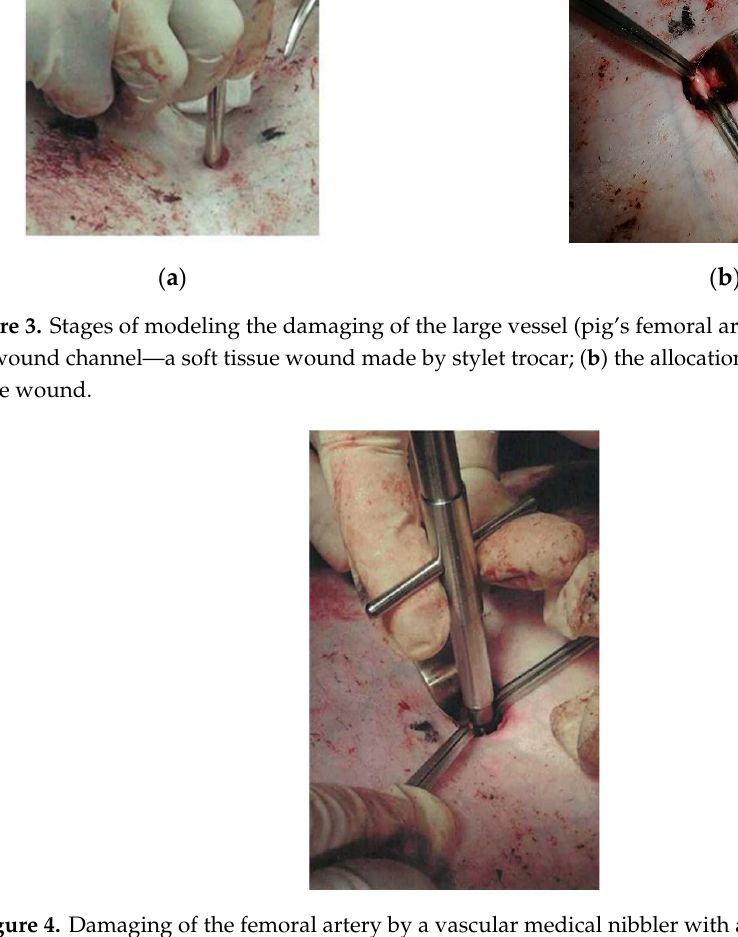
Figure 4. Damaging of the femoral artery by a vascular medical nibbler with a diameter of 6 mm.